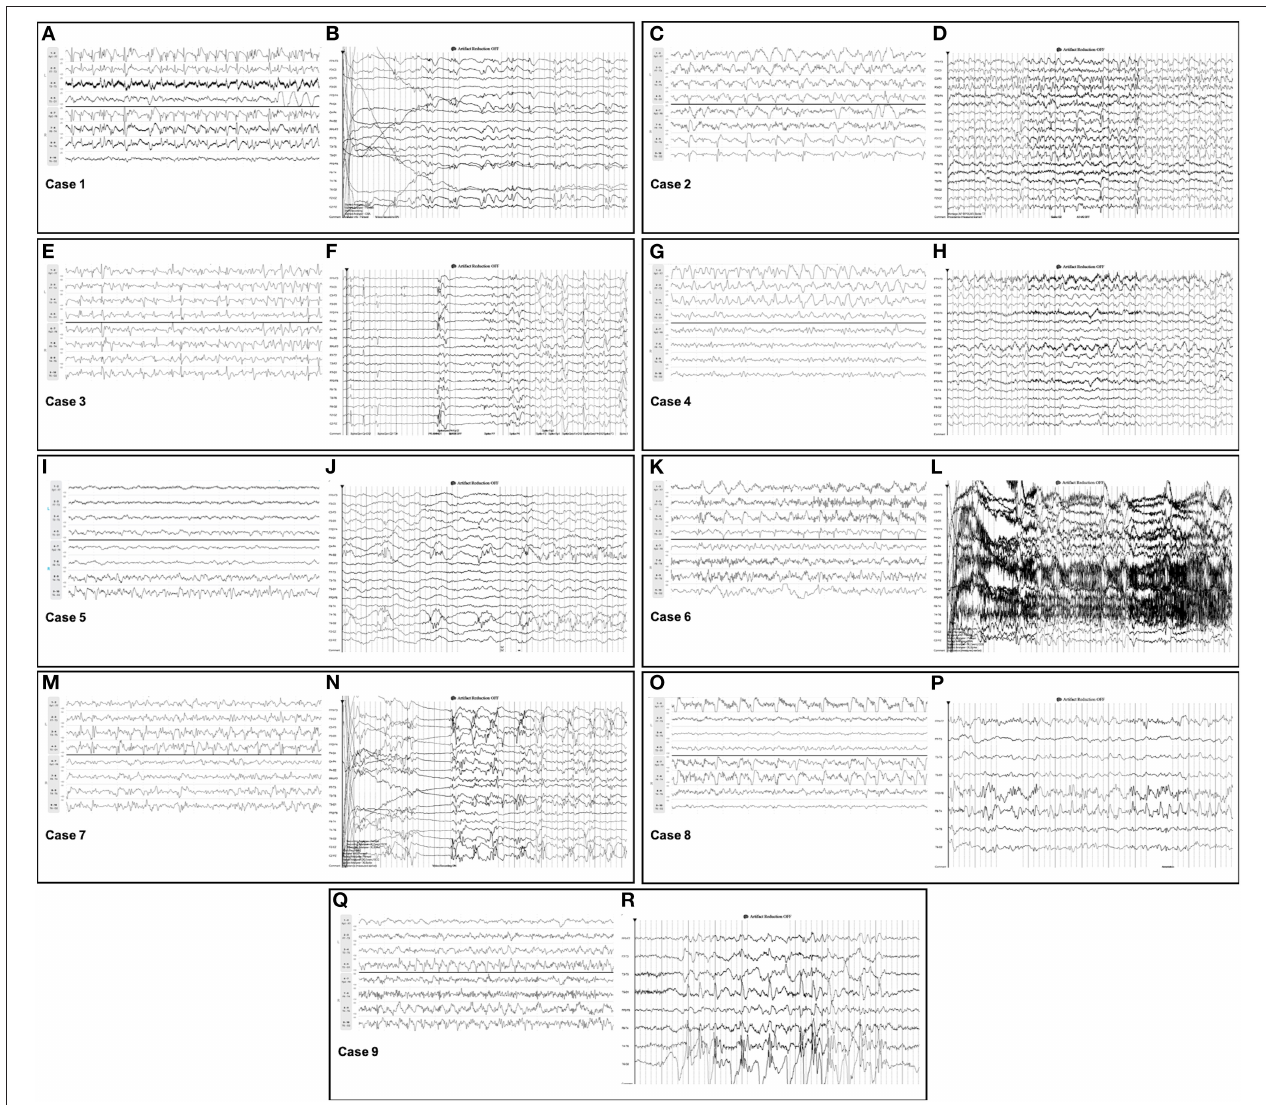
FIGURE 1 | Seizures detected on Rapid-EEG and conventional EEG. Seizures detected on both Rapid-EEG (left image within each case panel) and conventional EEG (right image within each case panel) in cases 1–9 displayed similar electrographic morphology and laterality. Individual case descriptions corresponding to panels (A–R) are provided in Supplementary Data